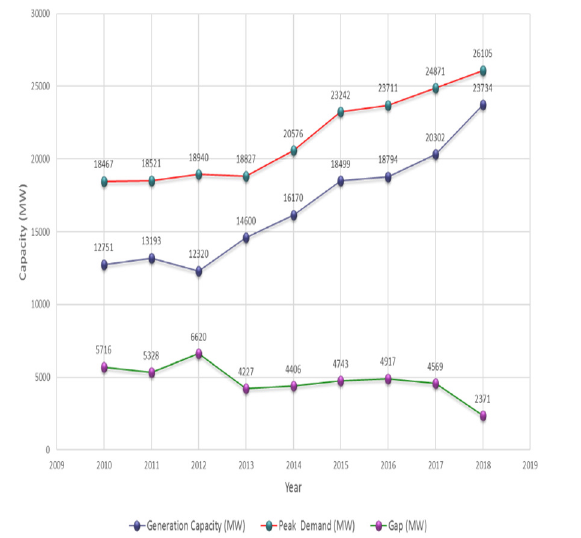
FIG. 1. PAKISTAN ENERGY DEMAND SUPPLY STATISTICS (CALCULATED FROM HDIP PROVIDED CAPACITY PROJECTION WITH ENERGY DEMAND